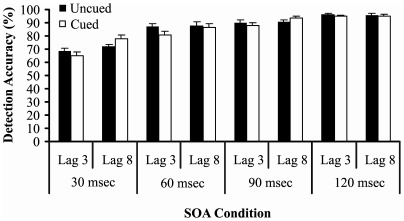
T1 accuracy across every combination of lag and SOA.T1 accuracy did not differ between cued and uncued trials. Error bars show standard errors of the mean.